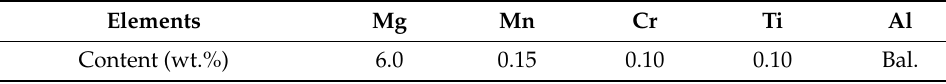
Table 1. The composition of the test alloy in this study. Elements Mg Mn Content